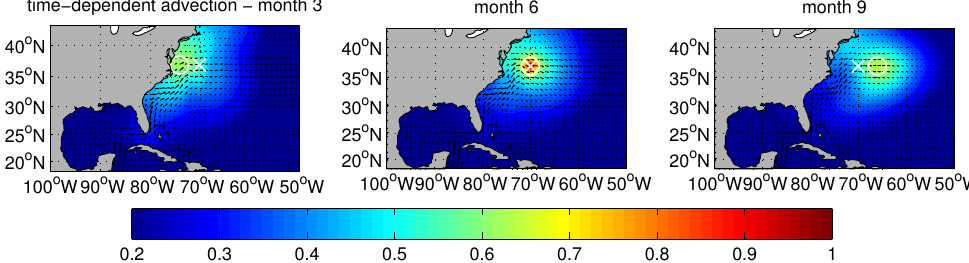
Fig. 7. 3-D case: background error covariance without (upper row) and with advection constraint (lower row) for a data point located at the cross and at month 6.